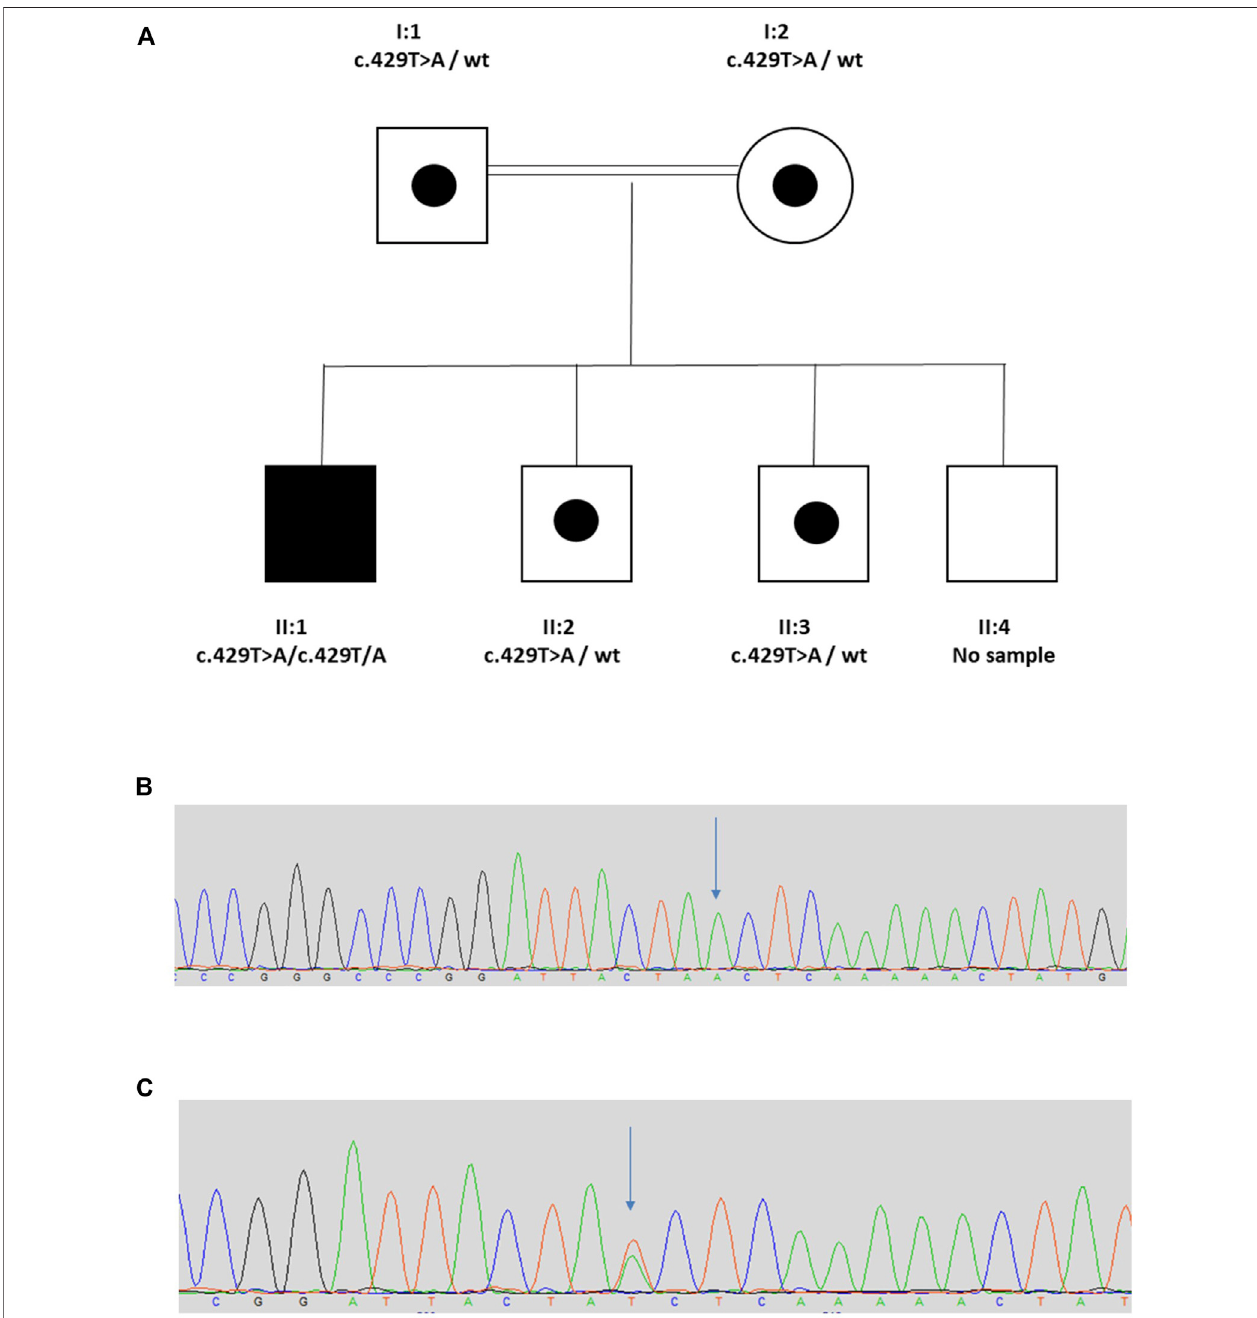
FIGURE 1 | Family 1. (A) . Pedigree of Family 1 with individual affected with UFS (II:1) shaded. Dots represent clinically unaffected individuals con fi rmed to carry a HPSE2 heterozygous variant. (B,C) , Genomic sequence chromatograms, showing variant c.429T > A indicated by an arrow (B) homozygous variant for affected, (C) heterozygous variant for carriers. Please see Supplementary Video 1 for the grimace upon